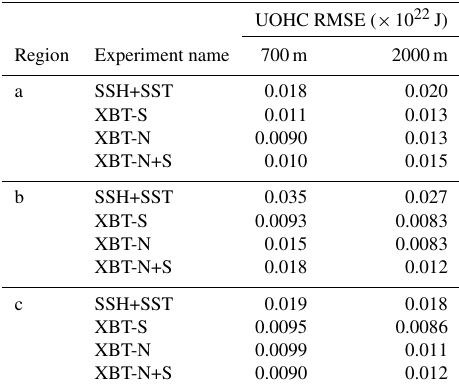
Table C1. Root mean square error (RMSE) in upper ocean heat content (UOHC) for regions a, b, c (see Fig. 3b), over the top 700m and top 2000m. The RMSE value is shown for each experiment, compared to the reference